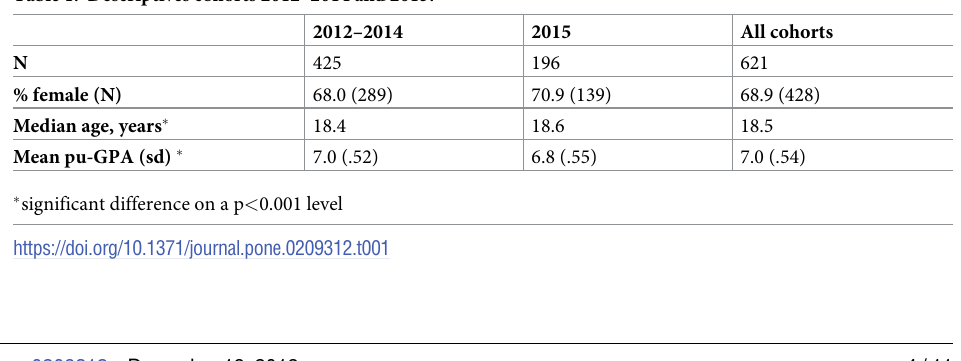
Table 1. Descriptives cohorts 2012–2014 and